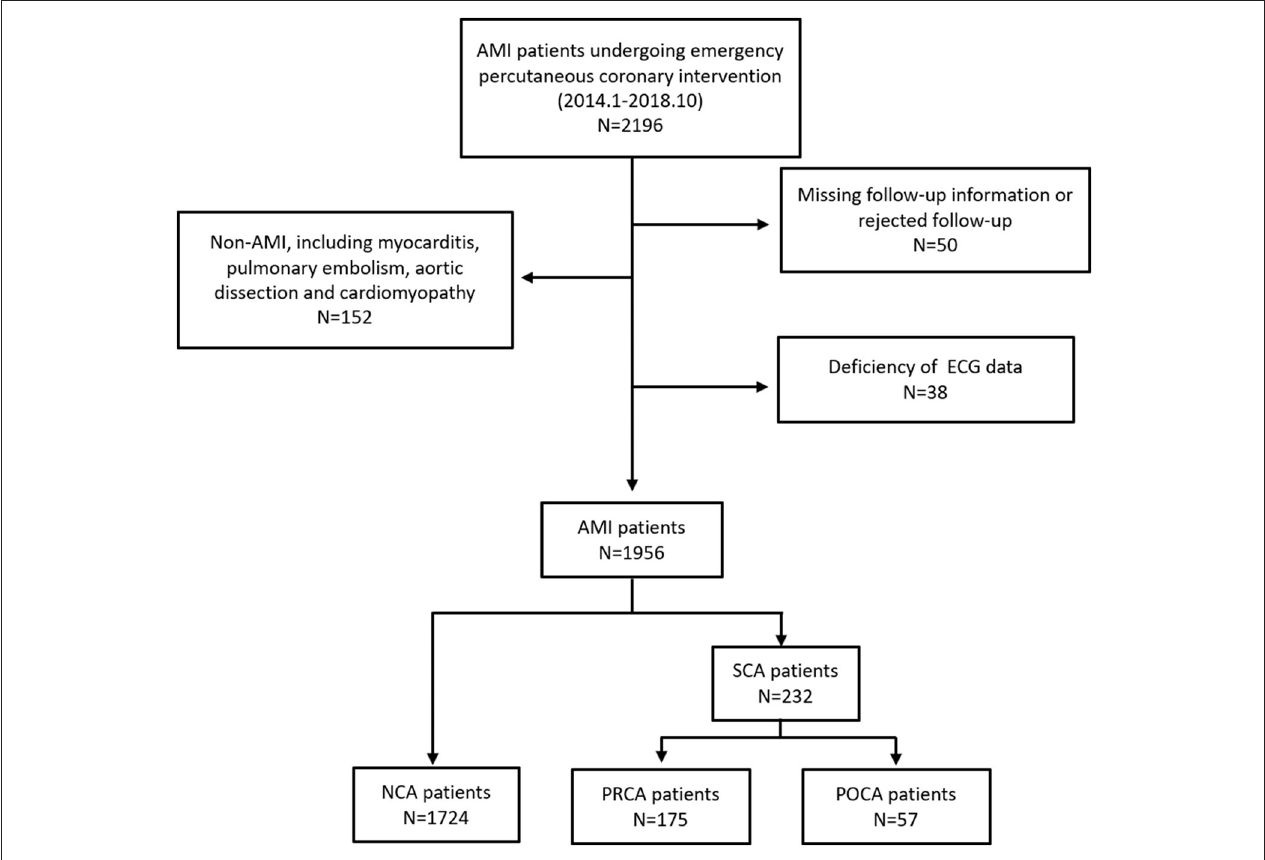
FIGURE 1 | Study population. NCA, non-cardiac arrest; POCA, post-revascularization cardiac arrest; PRCA, pre-revascularization cardiac